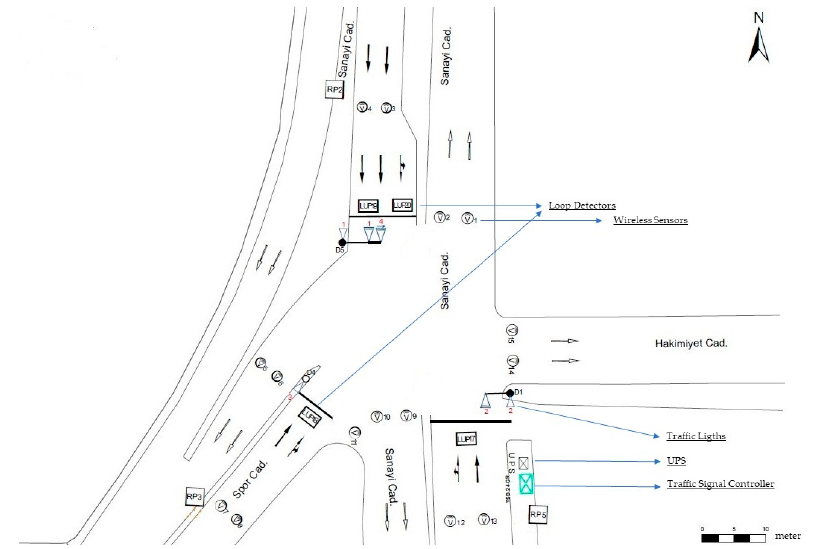
Figure 2 . Intersection plan with monitoring units Istanbul–Kartal Intersection No 4.1 [33] . Figure 2. Intersection plan with monitoring units Istanbul–Kartal Intersection No 4.1